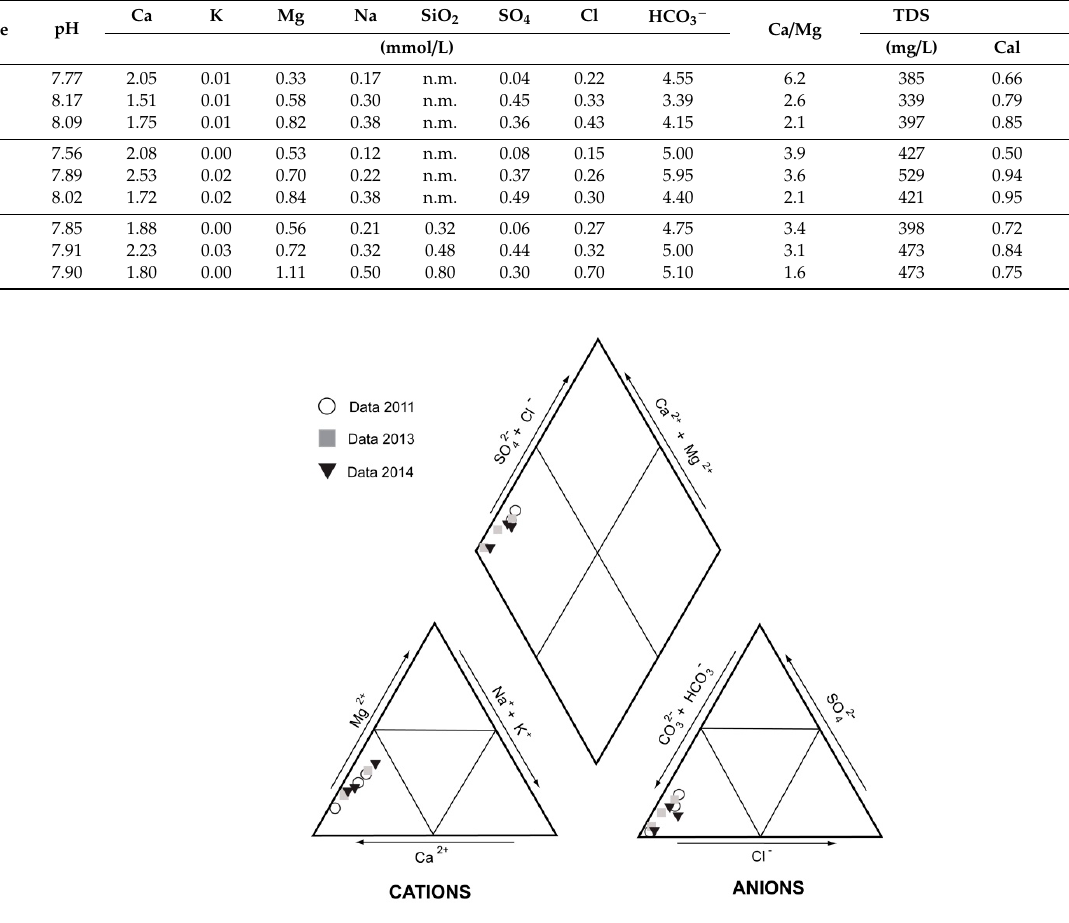
Figure 8. Representation of the composition of the water samples obtained in this study in a Piper– Hill